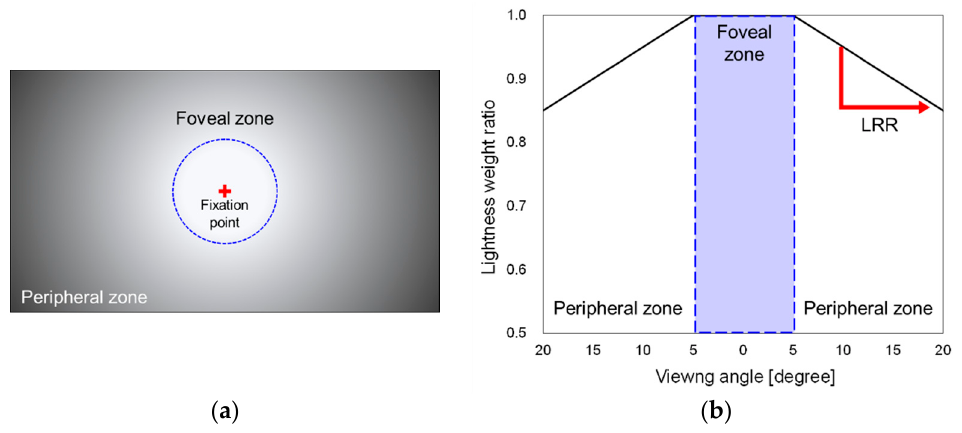
Figure 1. ( a ) A concept image of the peripheral dimming technique and ( b ) a lightness weight ratio depending on the viewing angle.